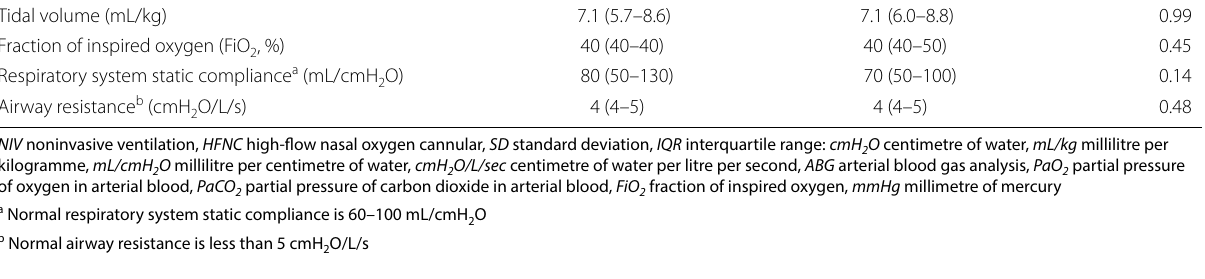
NIV noninvasive ventilation, HFNC high-flow nasal oxygen cannular, SD standard deviation, IQR interquartile range: cmH 2 O centimetre of water, mL/kg millilitre per kilogramme, mL/cmH 2 O millilitre per centimetre of water, cmH 2 O/L/sec centimetre of water per litre per second, ABG arterial blood gas analysis, PaO 2 partial pressure of oxygen in arterial blood, PaCO 2 partial pressure of carbon dioxide in arterial blood, FiO 2 fraction of inspired oxygen, mmHg millimetre of mercury a Normal respiratory system static compliance is 60–100 mL/cmH 2 O